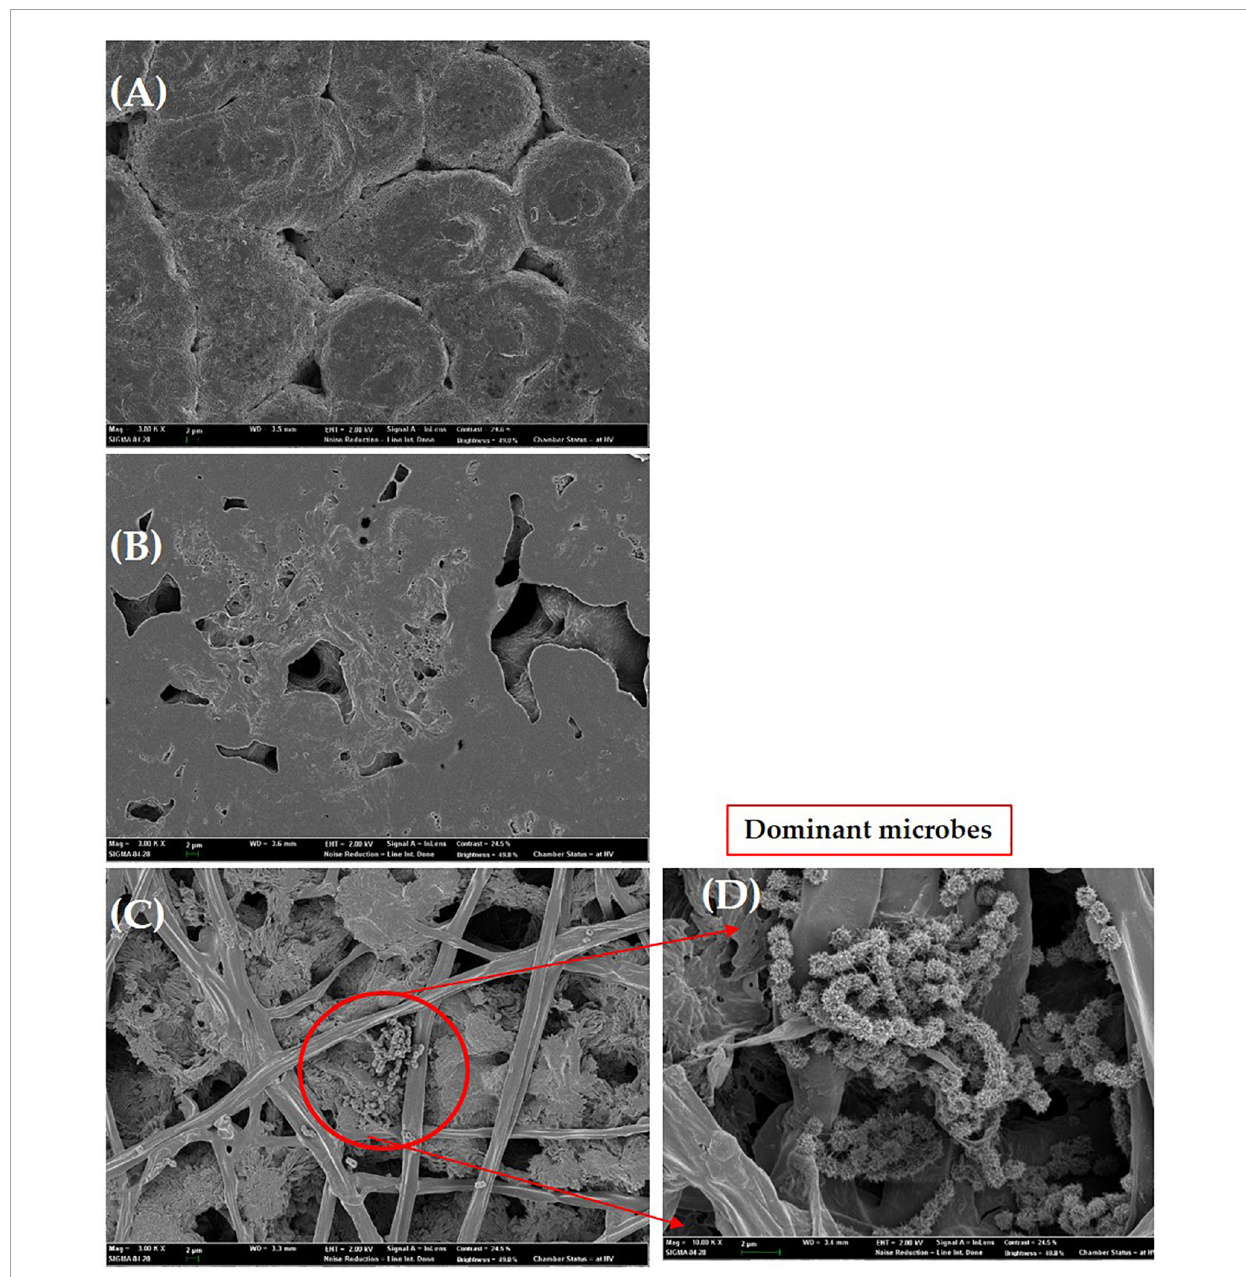
FIGURE9 Scanning electron micrographs of the PHB film. Control (A) , UV exposure after 14 days (B) , degradation of PHB film in soil after 6 days of incubation (C) , dominant microbes similar to Streptomyces species attached to PHB film (D) . Bar (A–D) , 2 µ